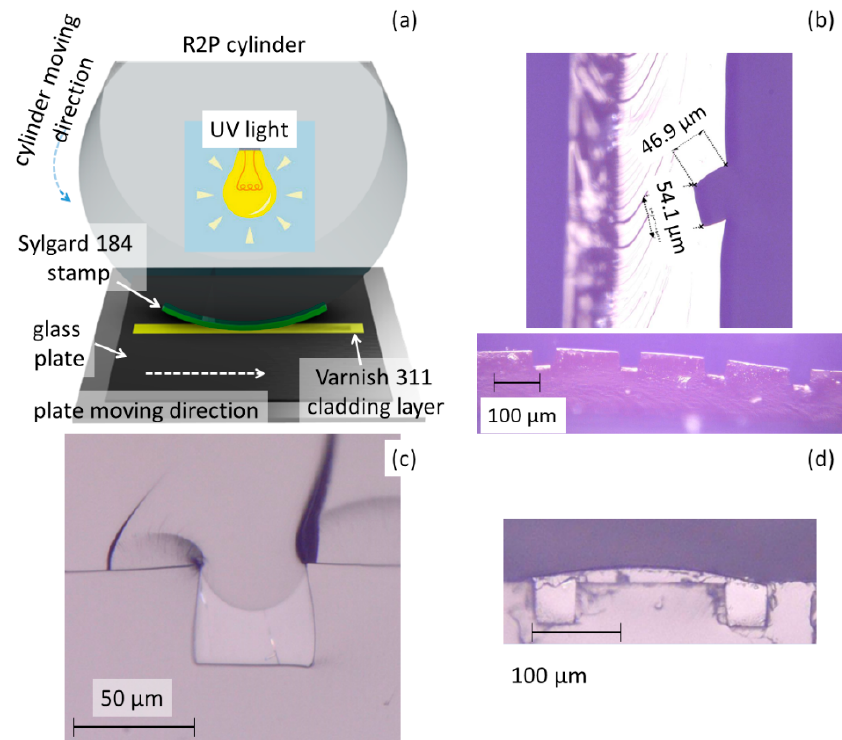
Figure 3. ( a ) Principle of the Roll-to-plate technology process. Results incorrectly set R2P process, KEYENCE microscope pictures ( b ) example of the fabricated U-groove channel in Lumogen OVD Varnish 311 by PDMS stamp, ( c ) example of the Lumogen OVD Varnish 311 U-groove fill in OrmoClear ® FX core—channel is not filled correctly with the polymer core, ( d ) example of the Lumogen OVD Varnish 311 U-groove fill in OrmoClear ® FX core—two channels are over-covered with the polymer core